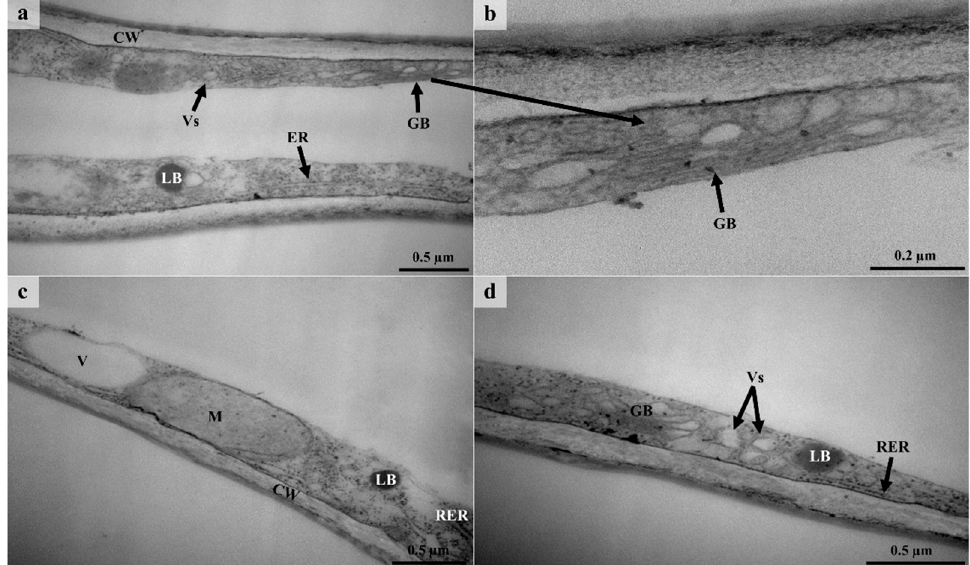
Figure 10. TEM micrographs of lepidote trichome radial cells. ( a ) Radial cell with thickened cell wall containing dense cytoplasm with vesicles, Golgi body, a lipid body, and endoplasmic reticulum at the periphery. The middle of this cell appears to be empty. ( b ) Higher magnification of Golgi body surrounded by dense cytoplasm. ( c ) A vacuole, mitochondrion, lipid body, and rough endoplasmic reticulum present along the radial cell wall. ( d ) Golgi body, rough endoplasmic reticulum, a lipid body, and numerous vesicles along the periphery of a radial cell wall. CW—Cell wall, Vs—Vesicle, V—Vacuole, M—Mitochondrion, RER/ER—Rough Endoplasmic Reticulum/Endoplasmic Reticulum, GB—Golgi body, LB—Lipid body.